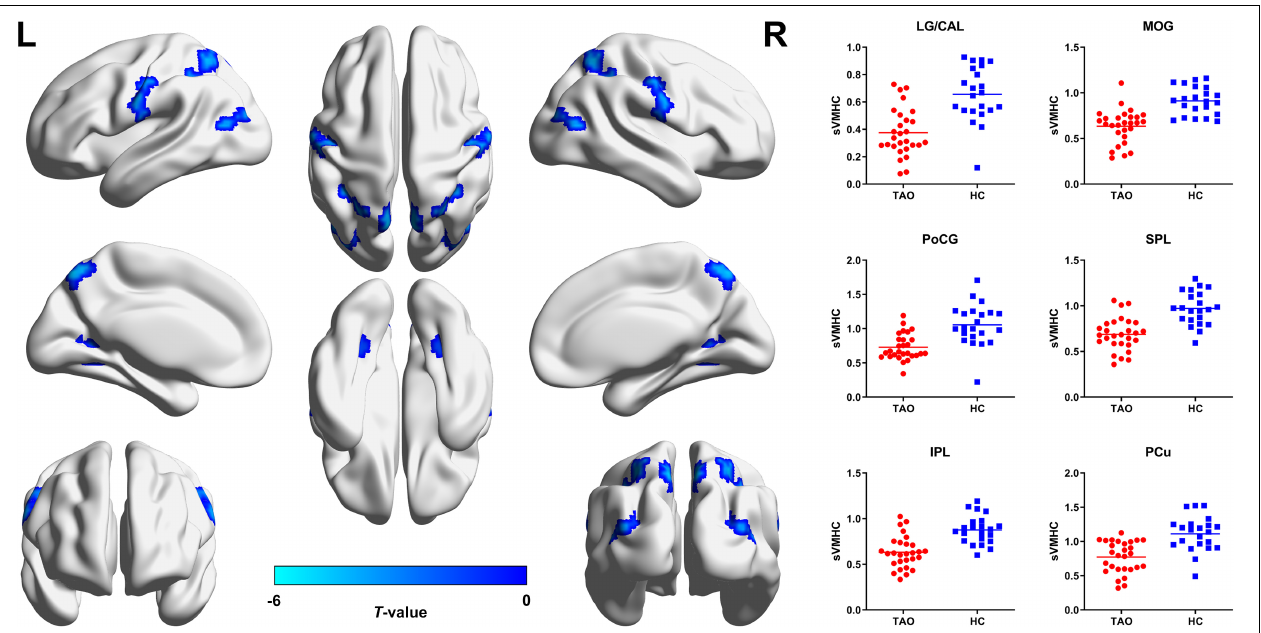
FIGURE 1 | Brain regions with significant static VMHC difference between TAO group and HCs. Compared with HCs, TAO group showed significantly decreased VMHC values in LG/CAL, MOG, PoCG, SPL, IPL, and PCu ( P < 0.05, cluster-level FWE corrected). The cold color denotes relatively lower values in TAO group, and the color bar indicates the t -value from two-sample t -test between TAO group and HCs. VMHC, voxel-mirrored homotopic connectivity; TAO, thyroid-associated ophthalmopathy; HCs, healthy controls; LG, lingual gyrus; CAL, calcarine; MOG, middle occipital gyrus; PoCG, postcentral gyrus; SPL, superior parietal lobule; IPL, inferior parietal lobule; PCu, precuneus; FWE, family-wise error; L, left; R, right; sVMHC, static VMHC.